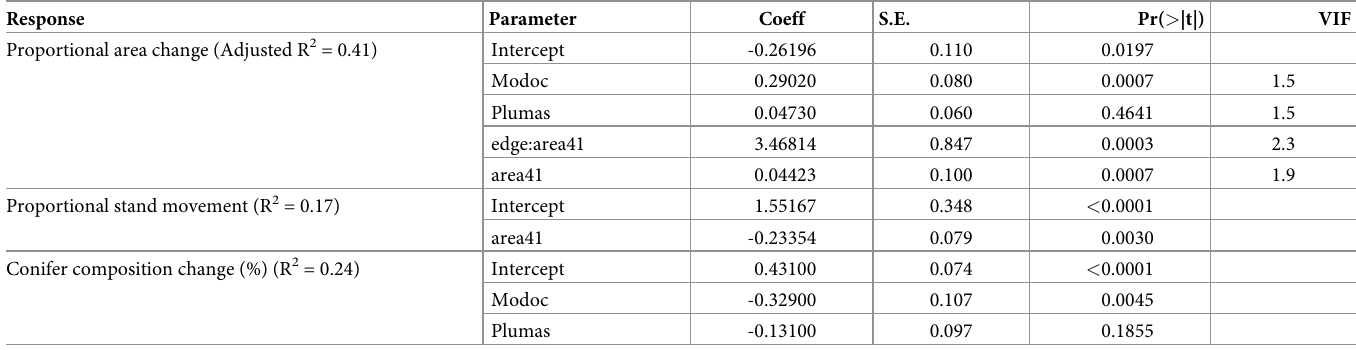
Table 4. Model summaries for selected models in the period of fire exclusion (1941–1993) for 33 stands in the proportional area change and conifer composition change models and 31 stands in the stand movement model. Variance inflation factor (VIF) quantifies multicollinearity, where a value of 10 or above indicates influen- tial multicollinearity